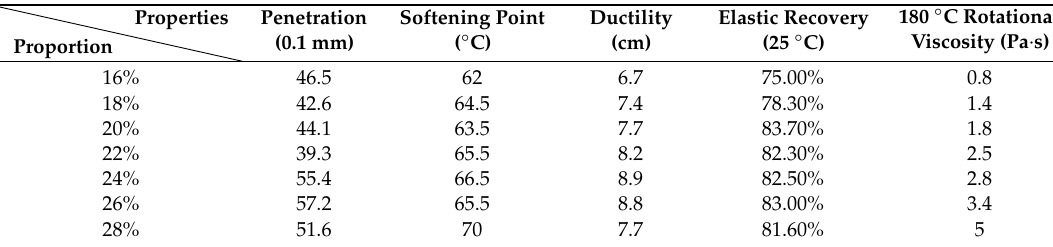
Table 7. Basic physical properties of di ff erent